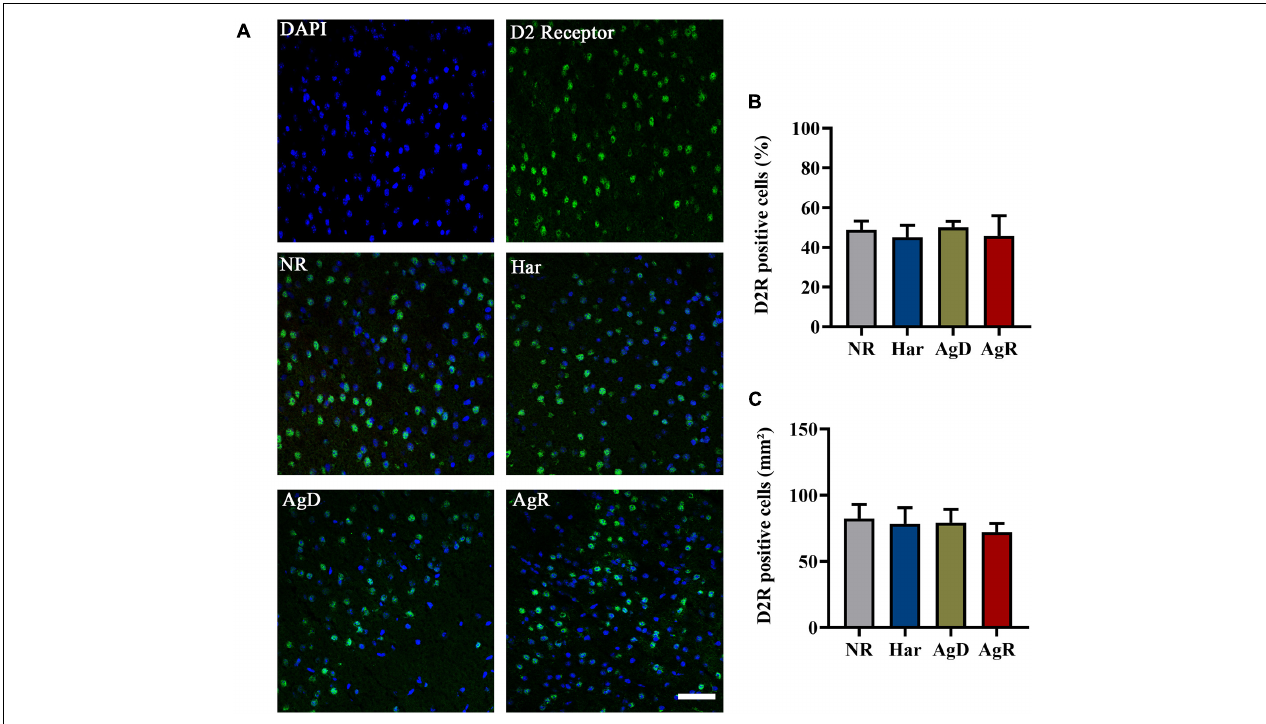
FIGURE 5 | Expression of the D2 dopaminergic receptor (D2R) in the cerebral cortex of mice submitted to the MSA. (A) Representative image showing nuclear staining with DAPI (blue) and D2R staining (green). Merging of D2R and DAPI staining is indicative in the categories: not regrouped (NR); harmonic (Har), attacked (AgD) and aggressor (AgR) in the frontal cerebral cortex. Bars: 50 pm. (B) Quantification of the percentage of cells positive for D2R. (C) Quantification of D2R-positive cells by the extension (mm2) of the prefrontal cortex activity according to the categories NR (gray bar), Har (blue bar), AgD (green bar) and AgR (red bar) (NR; n = 15, Har; n = 20, AgD; n = 25, AgR; n = 15 animals). Values are expressed as percentage and mean ± standard deviation (SD) of three independent experiments by Kruskal-Wallis and Dunn’s test.